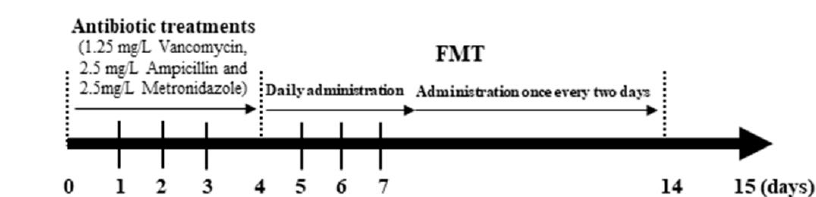
Figure 12. Experimental scheme for the FMT of the Tg2576 mice. ( a ) Treatment strategy. The WT and Tg2576 mice were divided into one of four groups: Non, AiDM+Vehicle, AiDM+TgFMT, and AiDM+WTFMT groups. The AiDM groups received the appropriate concentration of three antibiotics (vancomycin, ampicillin, and metronidazole) to remove intestinal bacteria. ( b ) Treatment schedule for FMT. After treatment with the three antibiotics for three days, the fecal suspensions of WT or Tg2576 mice were administrated orally into the AiDM-ICR mice seven times over two weeks. Abbreviations: WT, wild-type; Tg, Tg2576 mice; FMT, fecal microbiota transplantation; TgFMT,